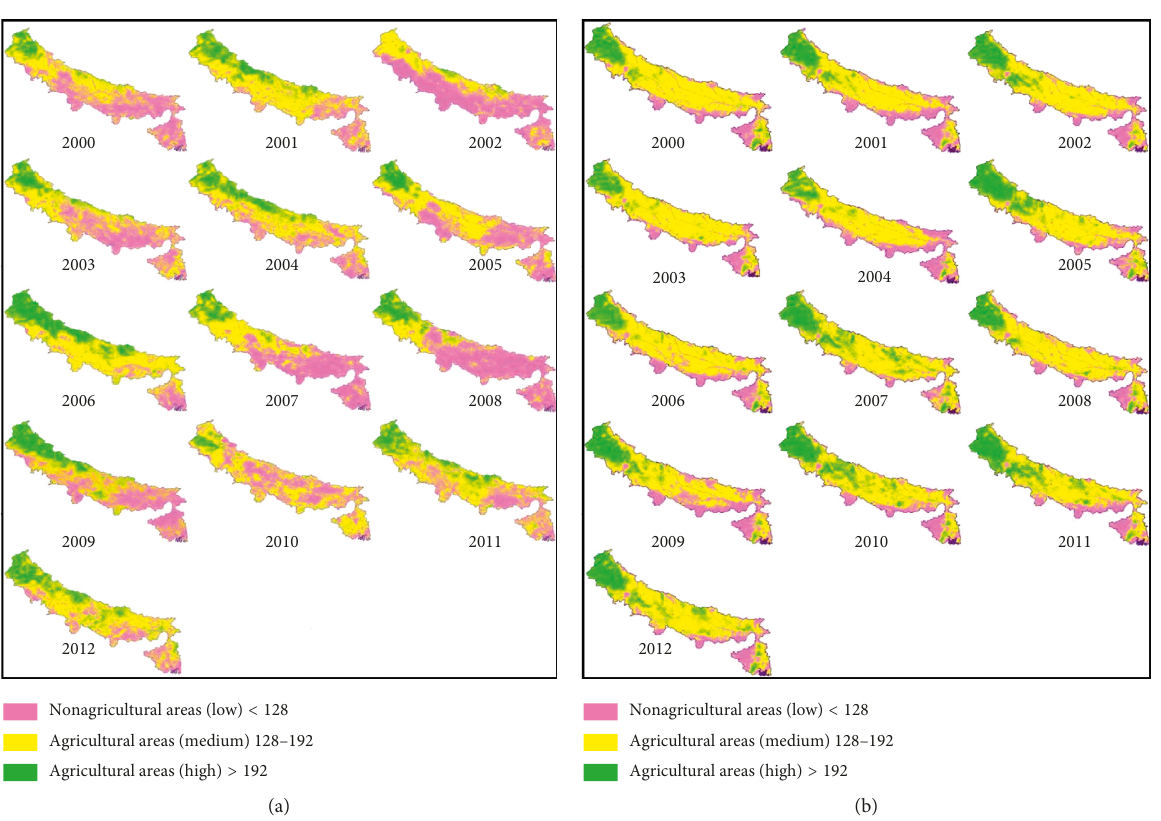
Figure 8: SPOT vegetation over the IGP for Kharif (a) and Rabi (b) as adopted from Koshal,